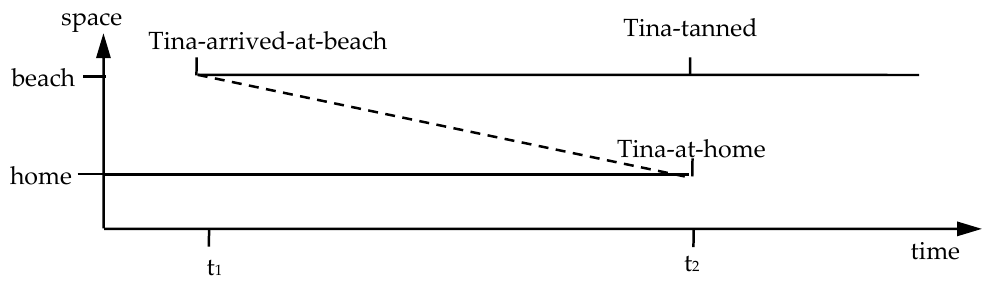
Figure 1. Tina’s spatial location as a function of time. The dashed line indicates a form of time travel (whether continuous or discontinuous).